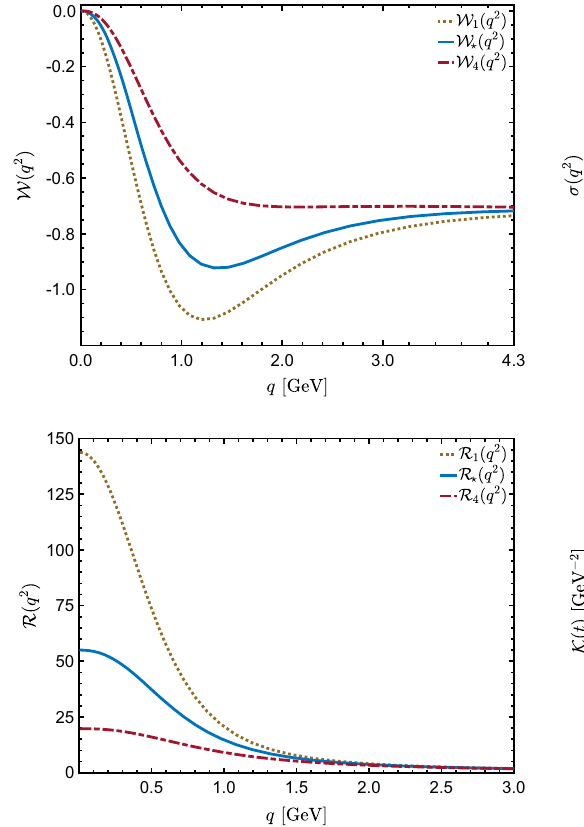
Fig. 5 Top left panel: The functions W i ( q 2 ) obtained using V 1 ((cid:7) 2 ) (brown dotted), V (cid:20) ((cid:7) 2 ) (blue continuous), and V 4 ((cid:7) 2 ) (red dashed- dotted), shown in Fig. 4. Top right panel: The corresponding σ 1 ( q 2 ) ,